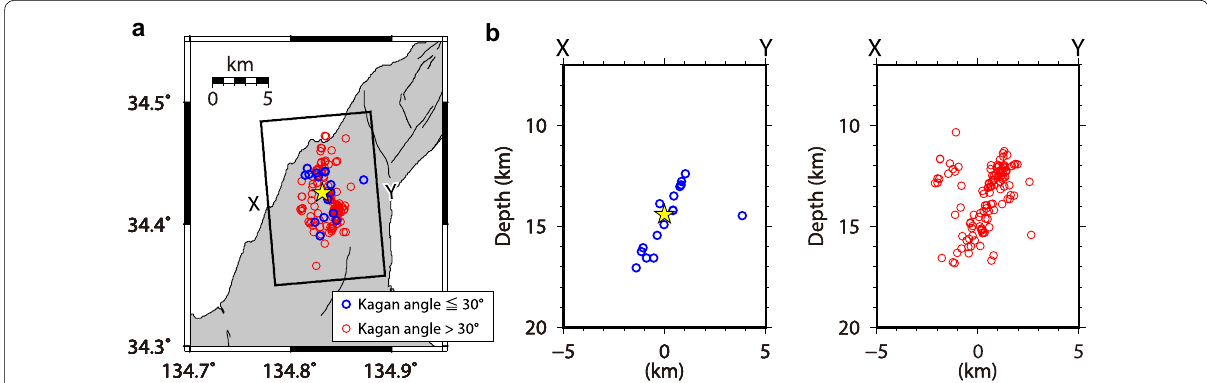
Fig. 7 Kagan’s angle (Kagan 1991) of aftershock focal mechanisms relative to the mainshock. a Map view and b cross-section. Blue and red circles indicate Kagan’s angle below and above 30°, respectively. The hypoDD location of the mainshock is shown by a yellow